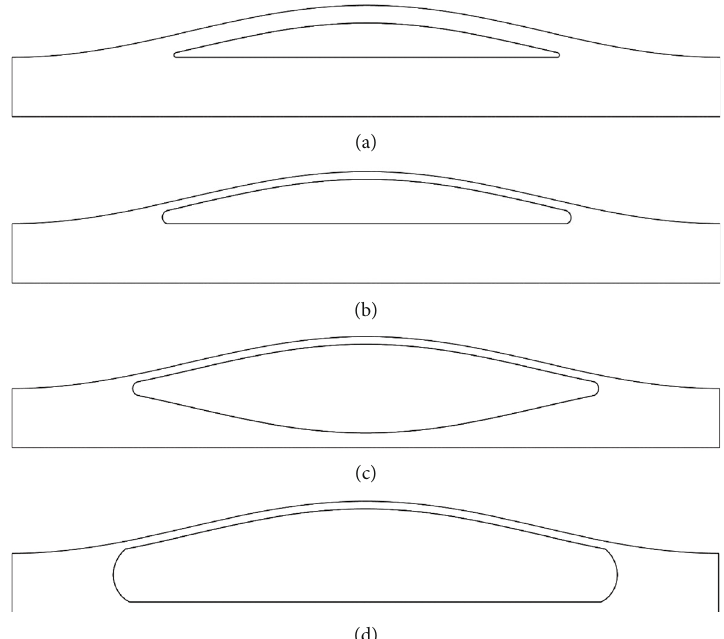
Figure 1: Geometry of a 50% stenosis and the pattern of lipid extension into the arterial wall. (a) G1: thick fi brous cap with smaller lipid core. (b) G2: plaque with thin fi brous cap and no extension of lipid core into the arterial wall. (c) G3: normally extended. (d) G4: overly extended lipid core.